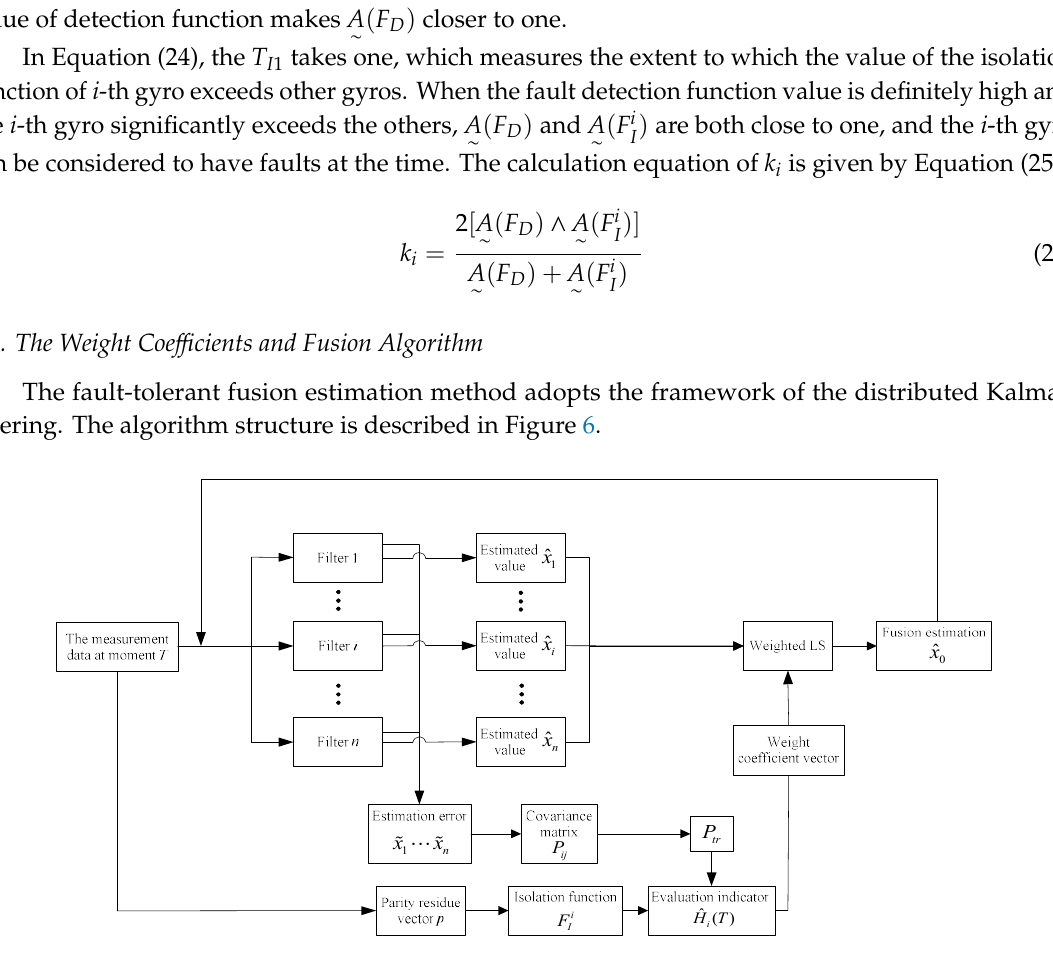
Figure 6. The process of the fault-tolerant fusion estimation method.